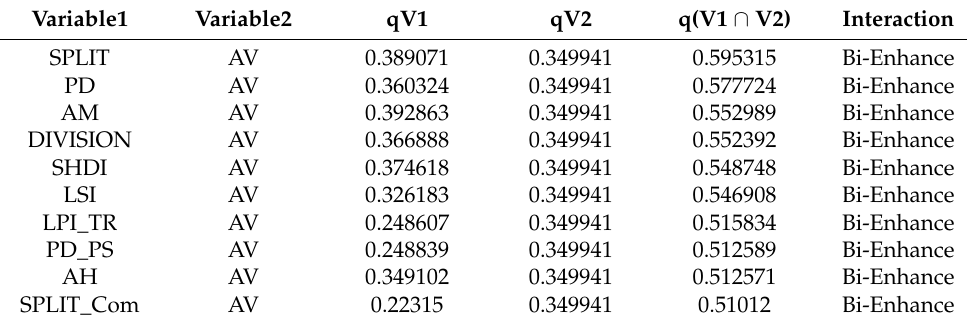
Table 4. Ten interaction detector results with the highest q-values.